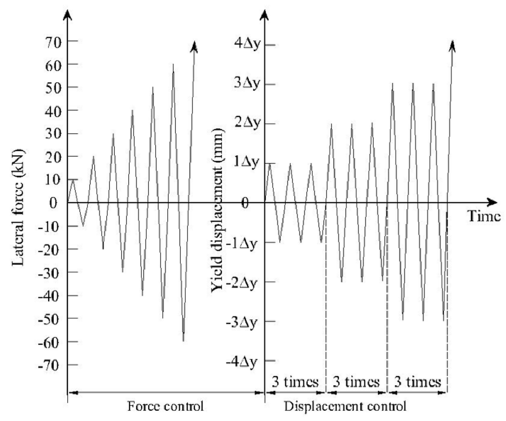
Figure 4. Typical testing protocol.